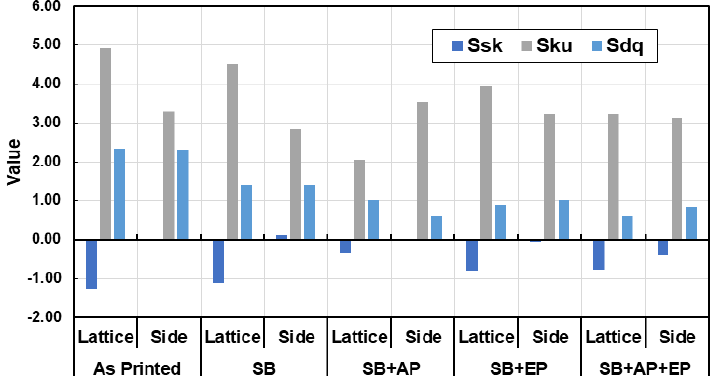
Figure 20. Hybrid parameters measured for the lattice joint and side planar surfaces. (Ssk: skew- ness, Sku: kurtosis, Sdq: root mean square gradient, SB: sandblasting, AP: abrasive polishing, EP: electropolishing.)